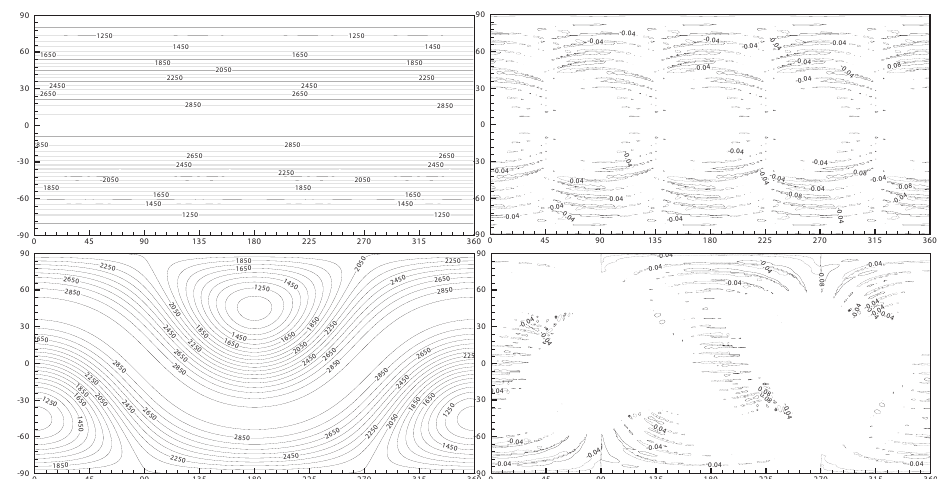
Figure 8. Numerical results and absolute errors of water depth for case 2 on grid G 12 at day 5. Shown are water depth (top left) and absolute error (top right) of the flow with γ = 0 and water depth (bottom left) and absolute error (bottom right) of the flow with γ = π Table 3. Numerical errors and convergence rates for case 2 of the flow with γ = π